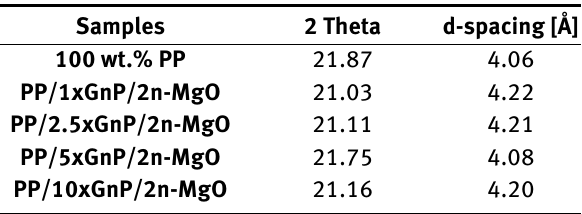
Figure 1: XRD curves of PP and it composites: (a) 100 wt.% PP, (b) PP/1xGnP/2n-MgO, (c) PP/2.5xGnP/2n-MgO, (d) PP/5xGnP/2n-MgO and (e) PP/10xGnP/2n-MgO.